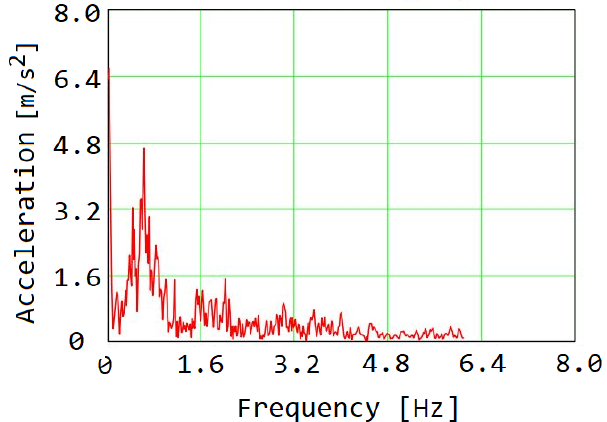
Figure 19. Acceleration versus frequency for the 4 March 1977 earthquake.